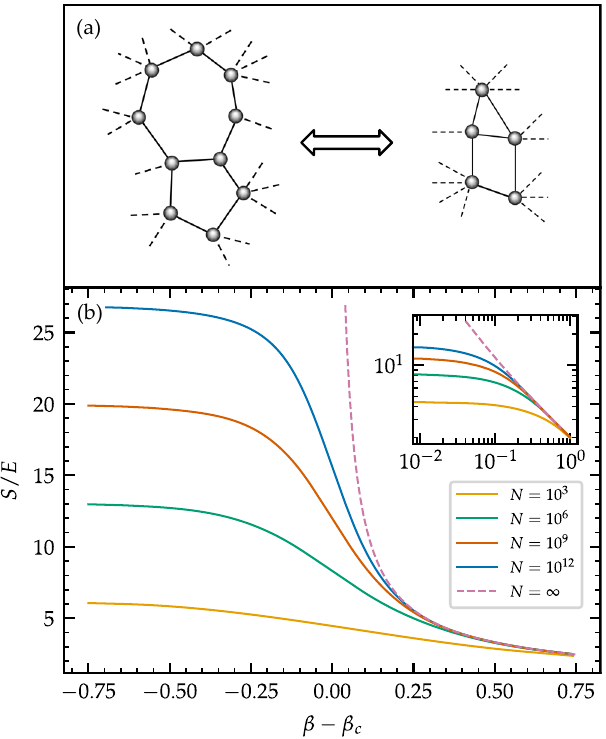
Fig. 1 Behavior of the network model as one crosses the critical temperature, both from an entropic as topological perspective. a Sketch illustrating the different organization of cycles in the two phases, short- range at low temperatures and long-range --of the order of the network diameter-- in the high temperature regime. b Entropy per link for S 1 geometric networks of different sizes with homogeneous degrees. Different curves are obtained by numerical integration (see Supplementary Note 1.2). The inset shows the same curves in the region β > β c in logarithmic